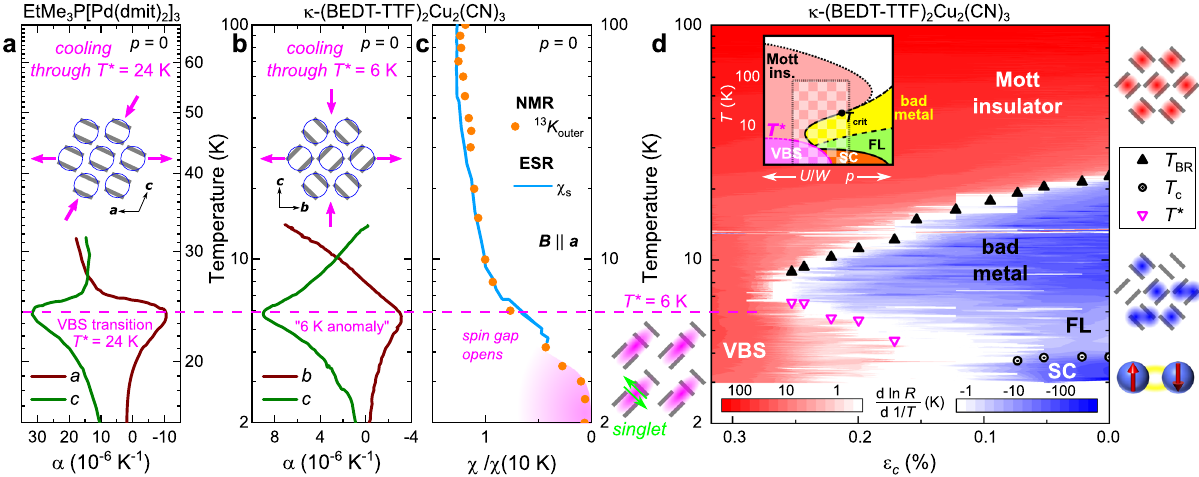
Fig. 4 | Transition to valence-bond-solid (VBS) state at ‘ 6K anomaly ’ . a , b The thermal expansion coef fi cient α yields similar in-plane anisotropy at the VBS tran- sition of EtMe 3 P[Pd(dmit) 2 ] 2 ( T ⋆ =24 K) 7 and at the ‘ 6K anomaly ’ of κ -(BEDT- TTF) 2 Cu 2 (CN) 3 19 . Note the different scales; data from refs. 7,19. c The rapiddrop of NMRKnightshift K andESRsusceptibility χ s ( B ∥ a )at T ⋆ =6Kevidencestheopening ofaspingap;datafromrefs.16,44. d Thephasediagramof κ -(BEDT-TTF) 2 Cu 2 (CN) 3 assembled from R ( T , ε c ) (Figs. 2c and 3) is underlaid with a false-color plot of